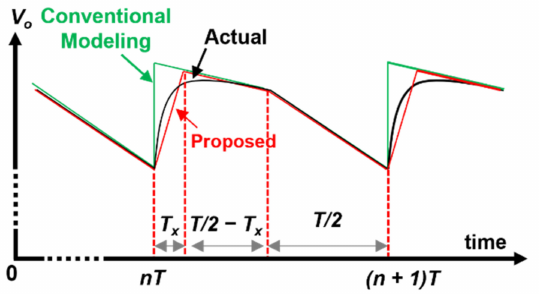
Figure 2. Output-voltage ripples of 1-stage linear charge